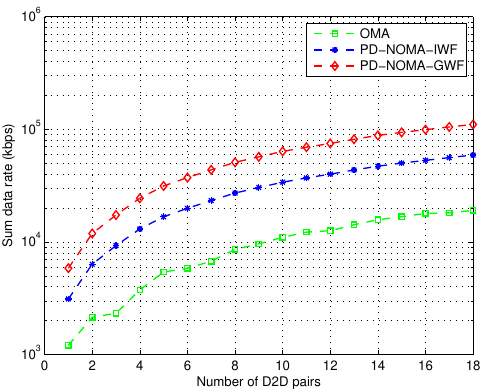
Figure 5. Performance of sum data versus number of D2D pairs with different power allocation method in OMA and NOMA.